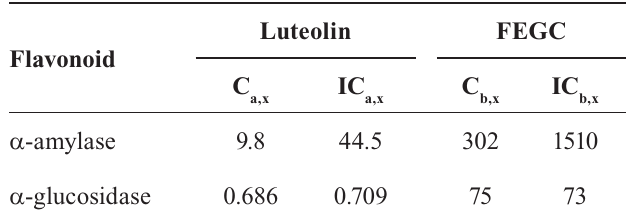
TABLE II - Activity of FEGC and luteolin as a combination against α -amylase and α -glucosidase